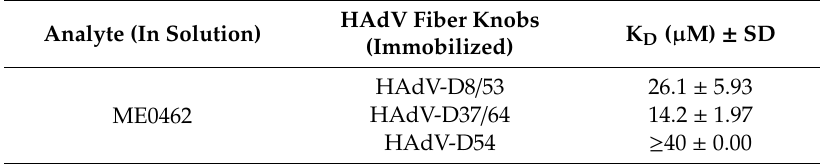
Table 2. Surface plasmon resonance (SPR) analysis of HAdV fiber knob interactions with